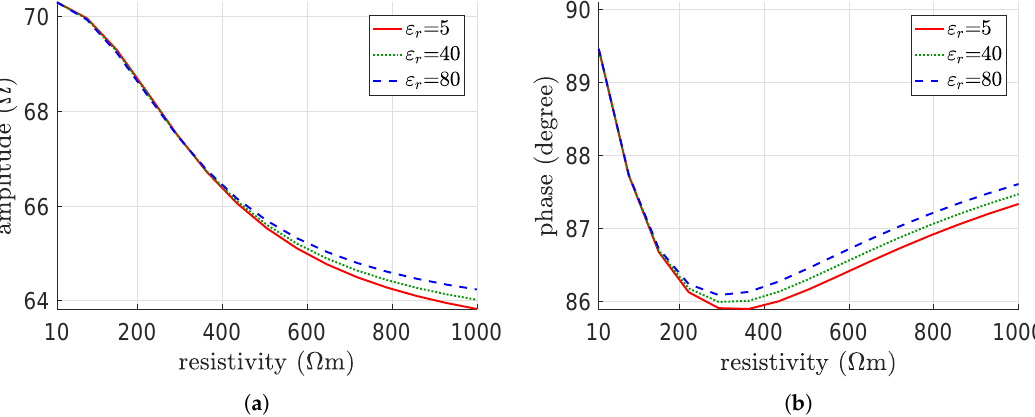
Figure 14. Equivalent impedance of the embedded coil ( Mod1 ) at 50 kHz for a concrete resistivity from 10 Ω m to 1000 Ω m, parametrized for ε r equal to 5, 40, and 80. Amplitude ( a ); phase ( b ).